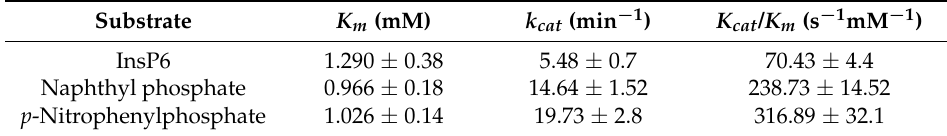
Table 1. Kinetic values of Pho16B under optimal pH and temperature conditions. All measurements were performed in triplicate.